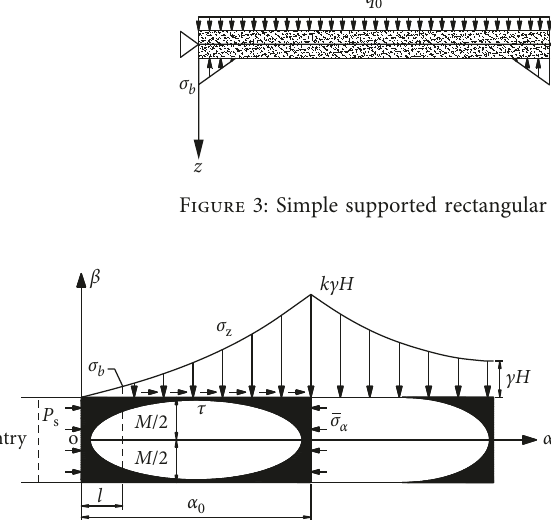
Figure 4: Model for calculating the normal stress distribution of the coal-roof interface of the coal rib.